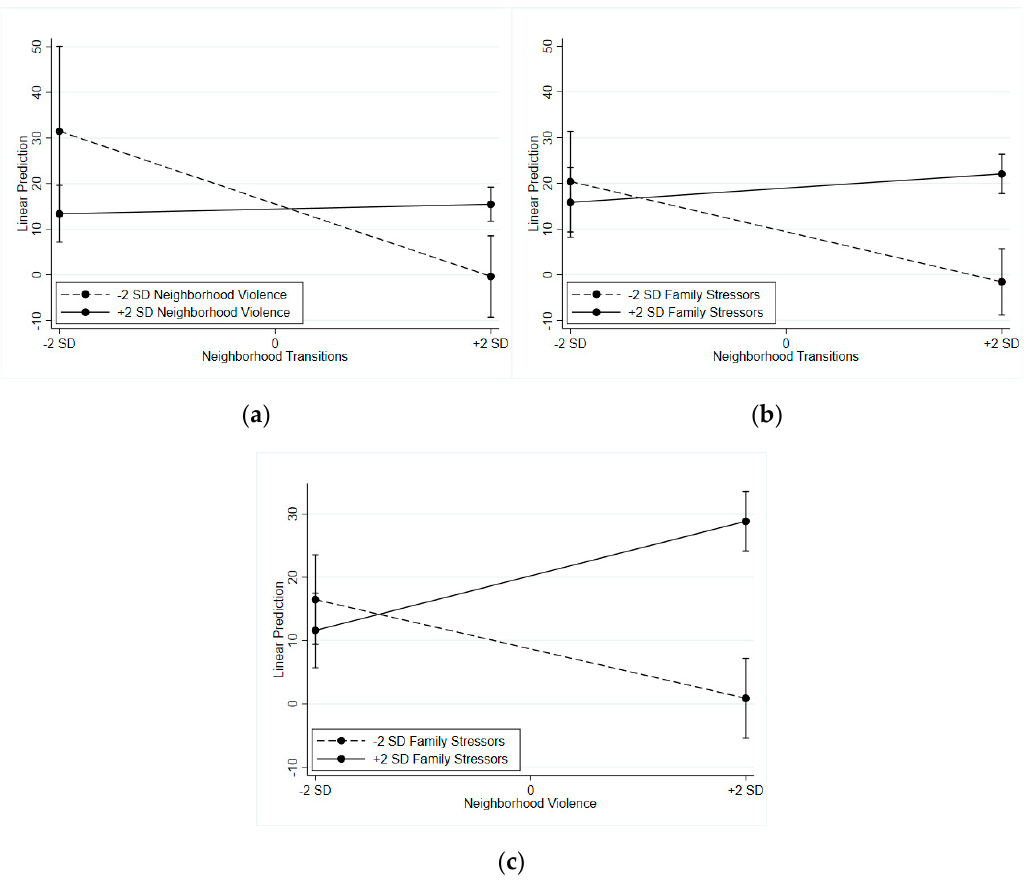
Figure 1. Plots of interaction effects predicting externalizing behavior. ( a ) Interaction between neighborhood transitions and neighborhood violence; ( b ) interaction between neighborhood transitions and family stressors; and ( c ) interaction between neighborhood violence and family stressors.